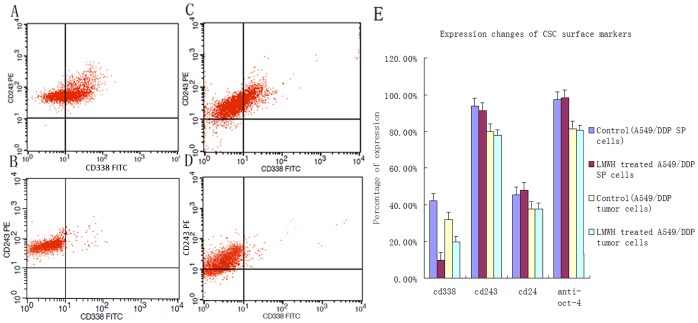
Flow-cytometry analysis of CSC marker expression induced by LMWH in A549/DDP side population (SP) cells or in A549/DDP SP xenograft tumor cells.(A) Expression of ABCG2 (CD338) in control SP cells and (B) induced by LMWH in A549/DDP SP cells. (C) Expression of ABCG2 (CD338) in controls tumor cells and (D) induced by LMWH in A549/DDP SP xenograft tumor cells. (E) Quantification of expression of CSC marker expression induced by LMWH in SP cells and xenograft tumor cells. LMWH significantly downregulated expression of ABCG2 by FACS (p<0.05).